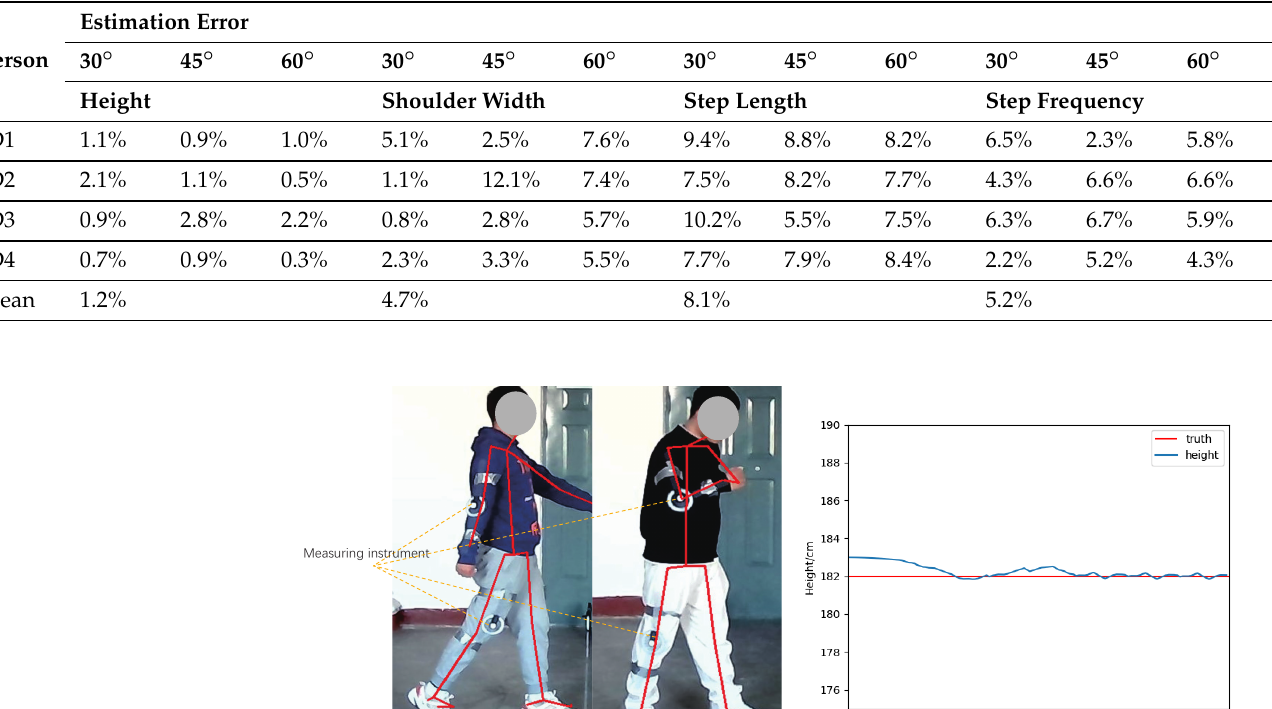
Table 2. Dynamic measurement error of physiological information.